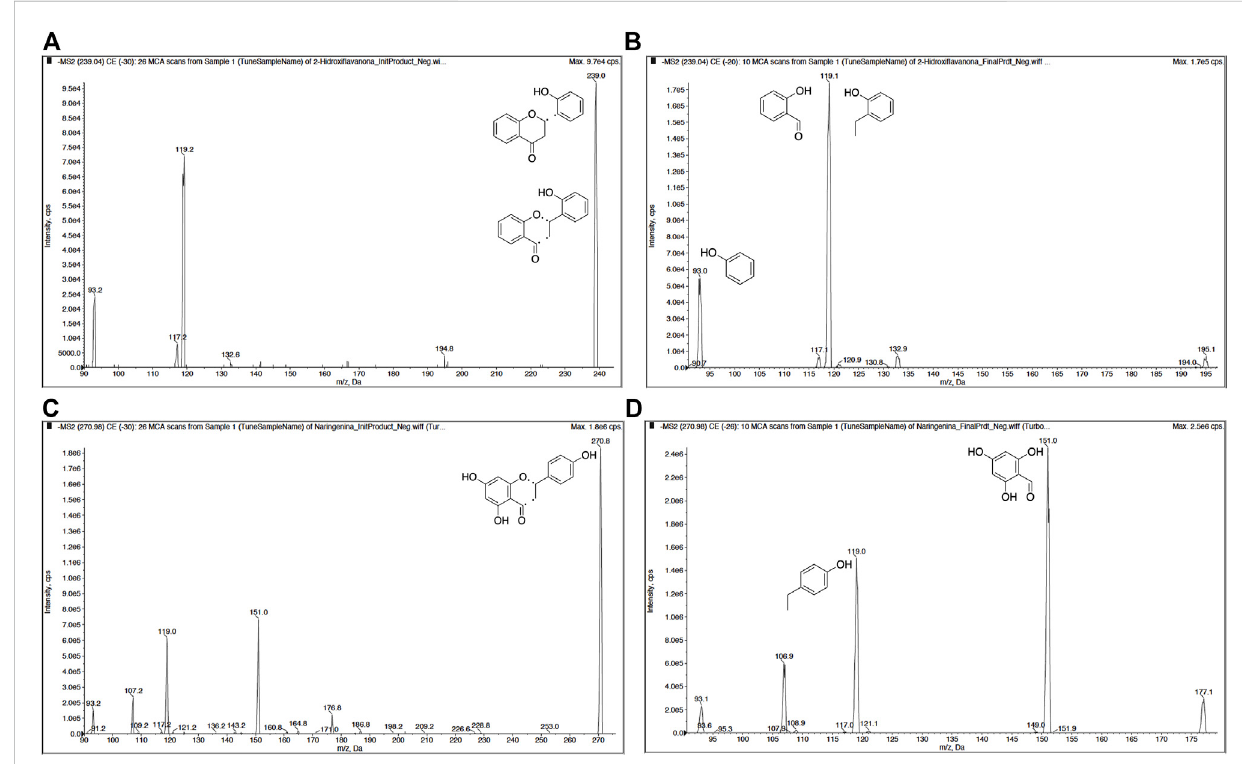
FIGURE 2 Product ion mass spectra of 2 ′ -hydroxy fl avanone (2HF) and Internal Standard (IS) in negative ionization mode. (A) The initial product of 2HF and (B) the fi nal product of 2HF with transitions m/z 239.0 → 119.0 and m/z 239.0 → 93.0. (C) The initial product of IS and (D) the fi nal product of IS